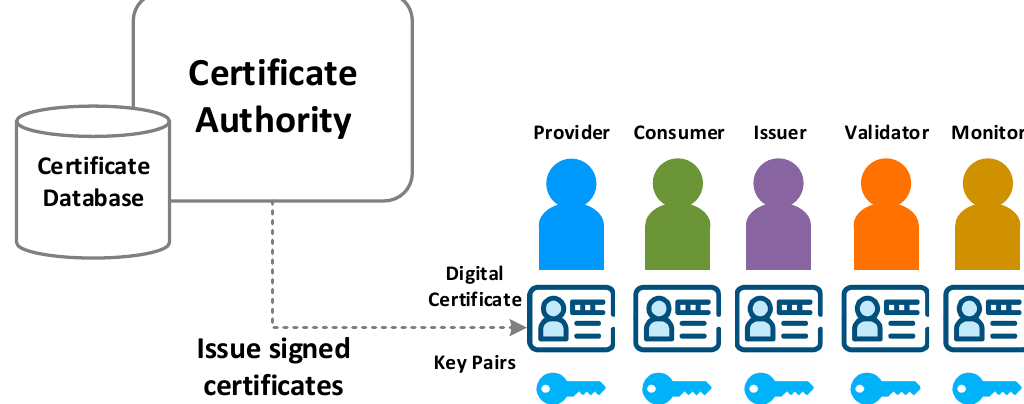
Figure 6. Digital identity issuing using certificate authorities (CA).